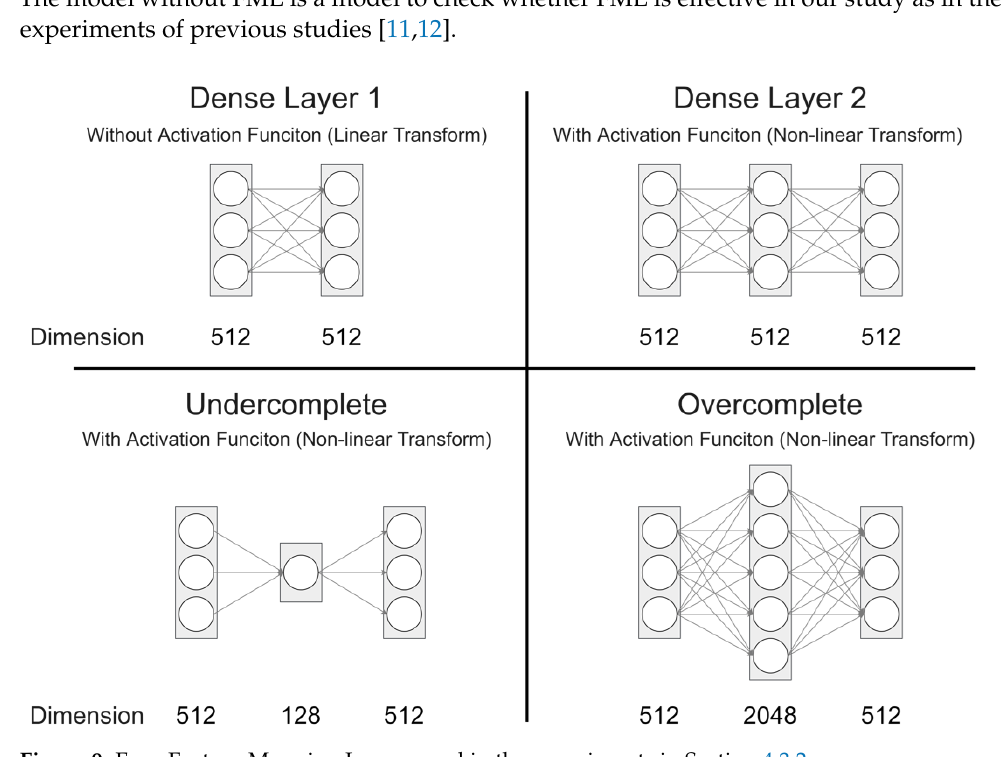
Figure 9. Four Feature Mapping Layers used in the experiments in Section